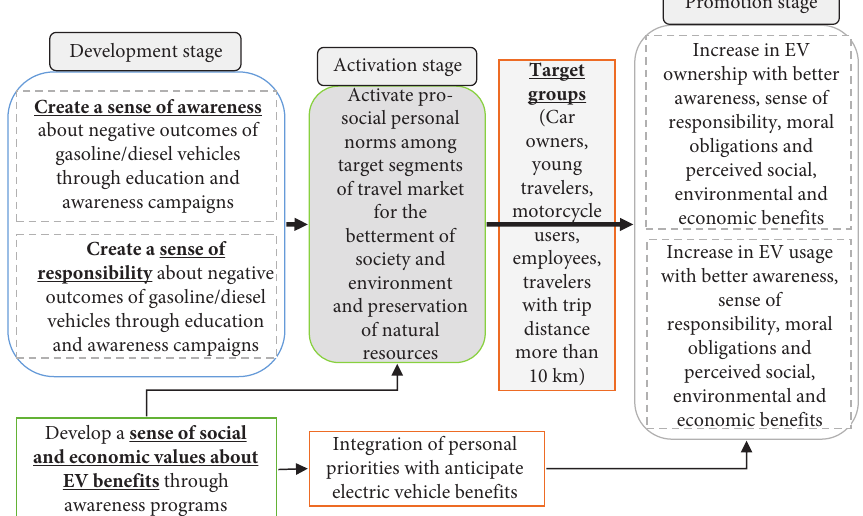
Figure 3: A conceptual framework of behavioral interventions to promote the EVs.